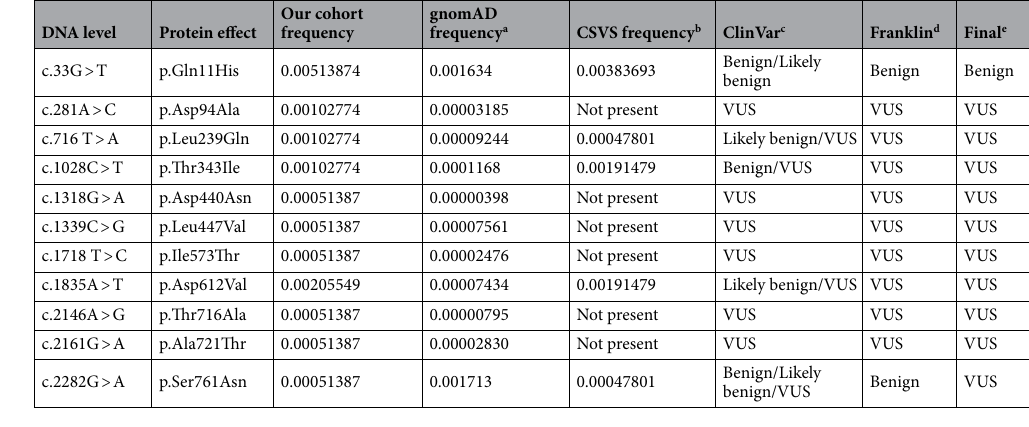
Table 3. Summary of rare BARD1 missense variants identified in the 1946 patients. VUS Variant of uncertain significance. a Total allele frequency for all populations described in gnomAD (https:// gnomad. broad insti tute. org/). b CSVS = Collaborative Spanish Variant Server. Here we show the frequency of the variants found in a local series of 2094 Spanish unrelated individuals that can be considered as controls. c Aggregate clinical significance from all records at ClinVar (https:// ncbi. nlm. nih. gov/ clinv ar/). d Clinical classification